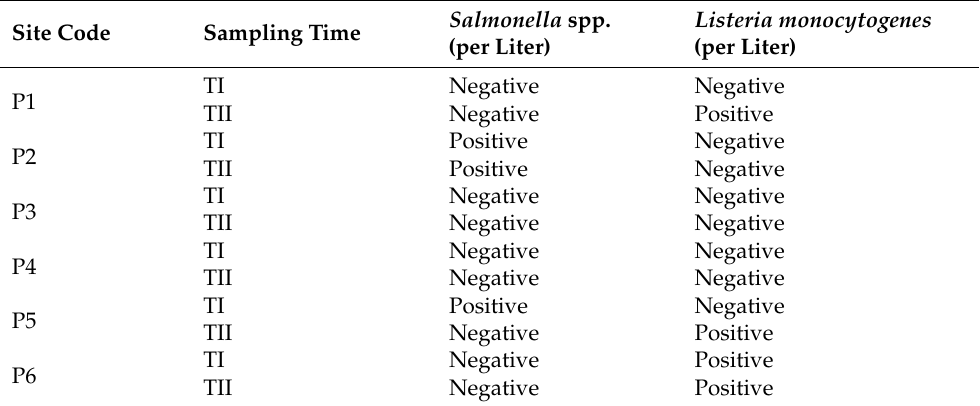
Table 3. Pathogens detection in each water body at two sampling times (September (TI) and October (TII)). Site Code Sampling Time